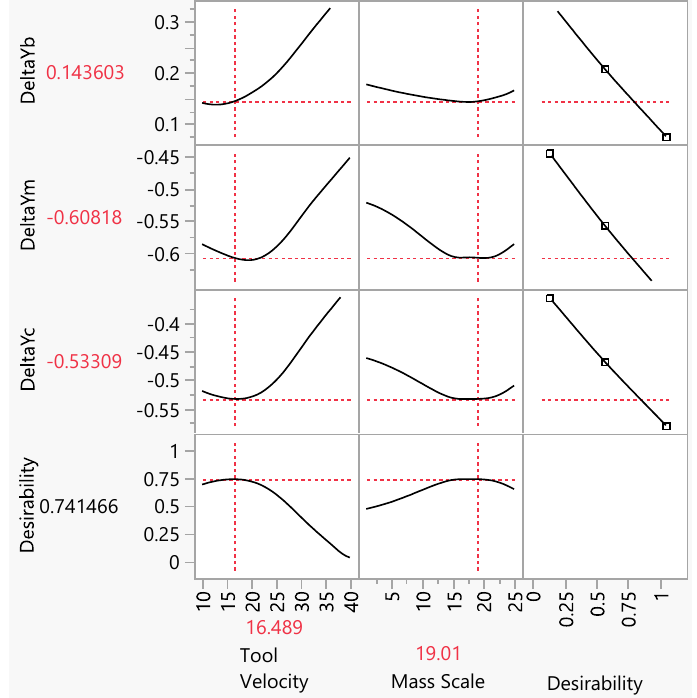
Materials 2022 , 15 , x FOR PEER REVIEW Figure 14. Profiler plot with optimized values for mesh size 1 × 1 mm. Figure 14. Profiler plot with optimized values for mesh size 1 × 1 mm. The neural network 3D scatterplot with cluster centres for the 3 × 3 mm mesh size delivered the optimal parameter combinations at the mass scale of 1 and lowest tool ve- locity of 10 m/s (Figure 15). Here, the selected combination of both minimal values of the input parameters is to be understood as constituting difficult conditions for the neural network evaluation. The pillowing parameters obtained by the neural network optimiza- tion are Δ Y c of 0.13 mm, Δ Y m of − 0.17 mm, and Δ Y b = 0.65 mm, and the parameters calcu- lated from the numerical FEM model are Δ Y c of − 0.42 mm, Δ Y m of − 0.02 mm, and Δ Y b = 0.67 mm. Here, the differences among the obtained pillowing results of both approaches are larger than those observed at mesh size of 1 × 1 mm. Furthermore, the spread of the pillowing curves is here larger than in the case of 1 × 1 mm. On the other hand, the calcu- lation times for larger element size are significantly shorter than those observed at the mesh size of 1 × 1 mm.